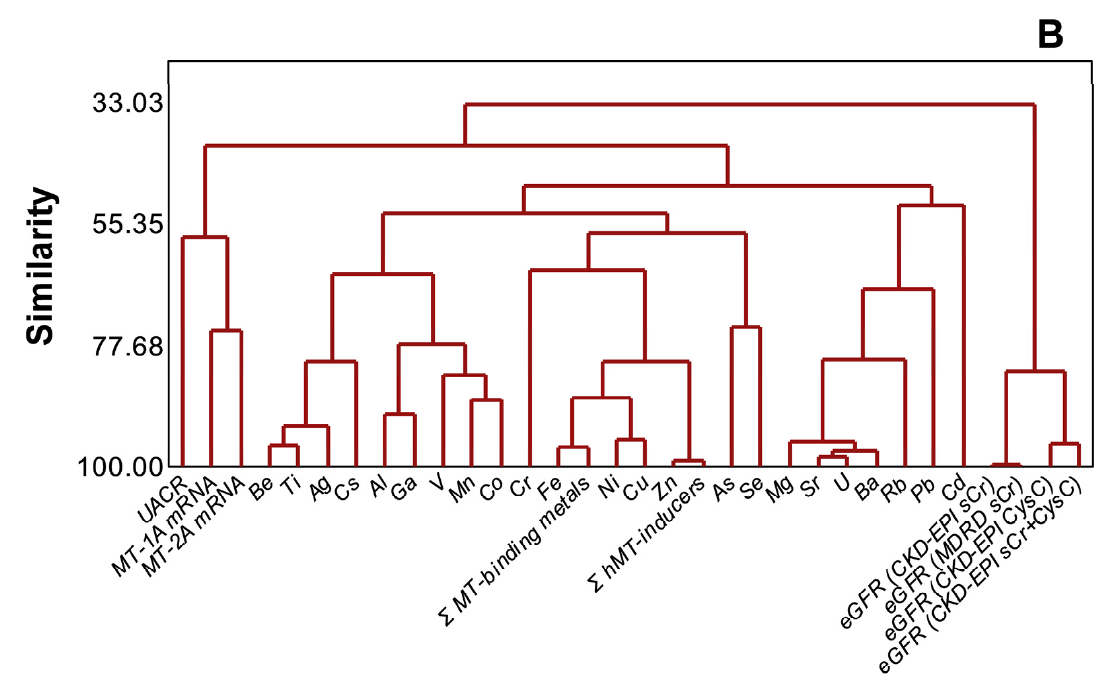
Figure 5. Distinct clustering of plasma metals, MT1A/2A transcripts, and kidney dysfunction markers in CKDu endemic Padaviya area (n = 97), ( A ) principal component analysis, ( B ) cluster dendrogram.